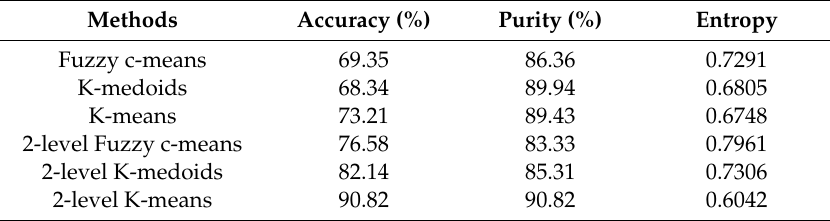
Table 3. Quantitative assessment of automatic segmentation methods.